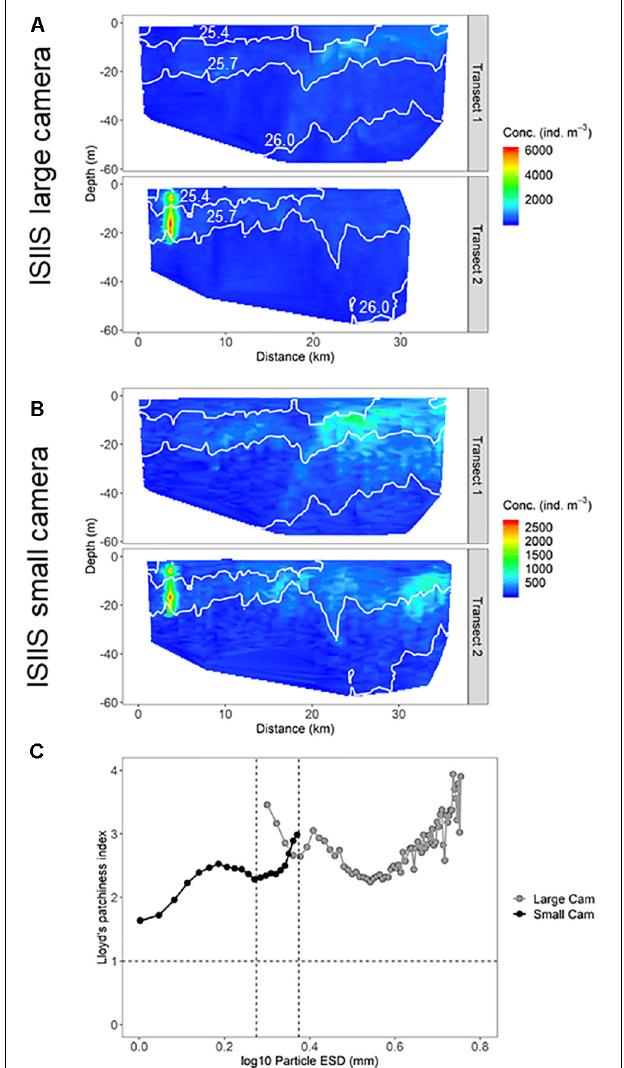
FIGURE 10 | Distribution of particles in the ISIIS (A) large and (B) small cameras that overlap in size (1.88–2.37 mm ESD). (C) Lloyd’s patchiness index (random distribution = 1. Higher values indicate more patchiness.) for particles vs. size detected by the two cameras on the ISIIS. The two vertical dotted lines indicate the size range where the two cameras